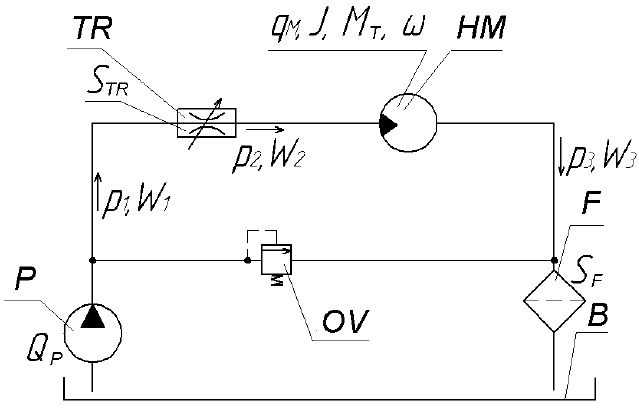
Fig. 1. Calculation scheme of the drive of dehydration of solid waste in garbage